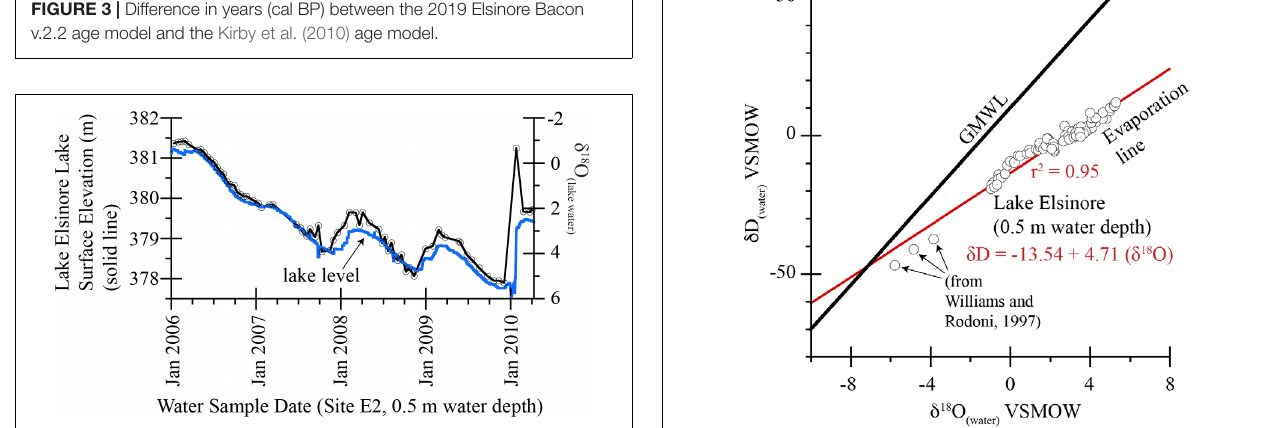
FIGURE 6 | Lake Elsinore water (0.5 m water depth) oxygen and hydrogen isotopic values plotted versus the GMWL. Note the strong departure from the GMWL by the Lake Elsinore δ 18 O ( lakewater ) values in response to evaporation.